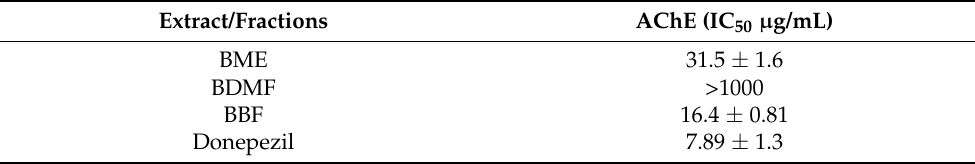
Table 3. The acetylcholinesterase (AChE) enzyme inhibition activity of BME, BDMF, and BBF.